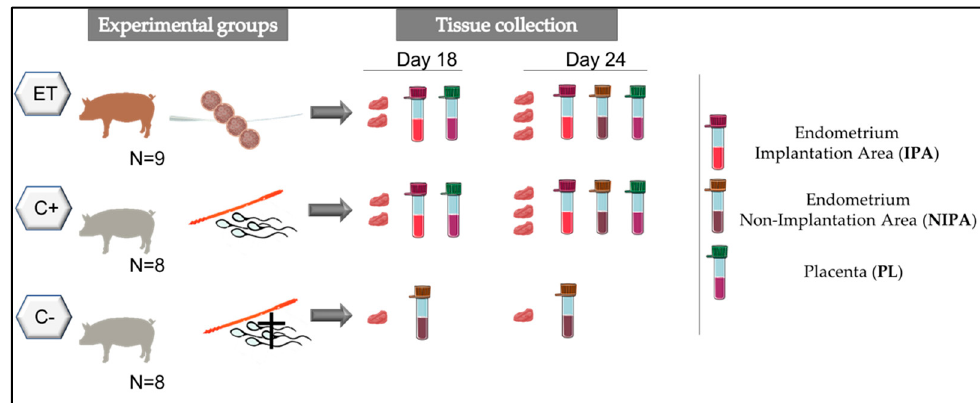
Figure 1. Schematic representation of the experimental design. Experimental groups: Sows subjected to surgical embryo transfer (ET), sows subjected to artificial insemination (C+), sows subjected to artificial insemination with dead sperm (C-). Tissue samples from different areas of the reproductive tract (Implantation area (IPA); non-implantation area (NIPA) or fetal placenta (PL) were retrieved after Day 18 or Day 24 of pregnancy.